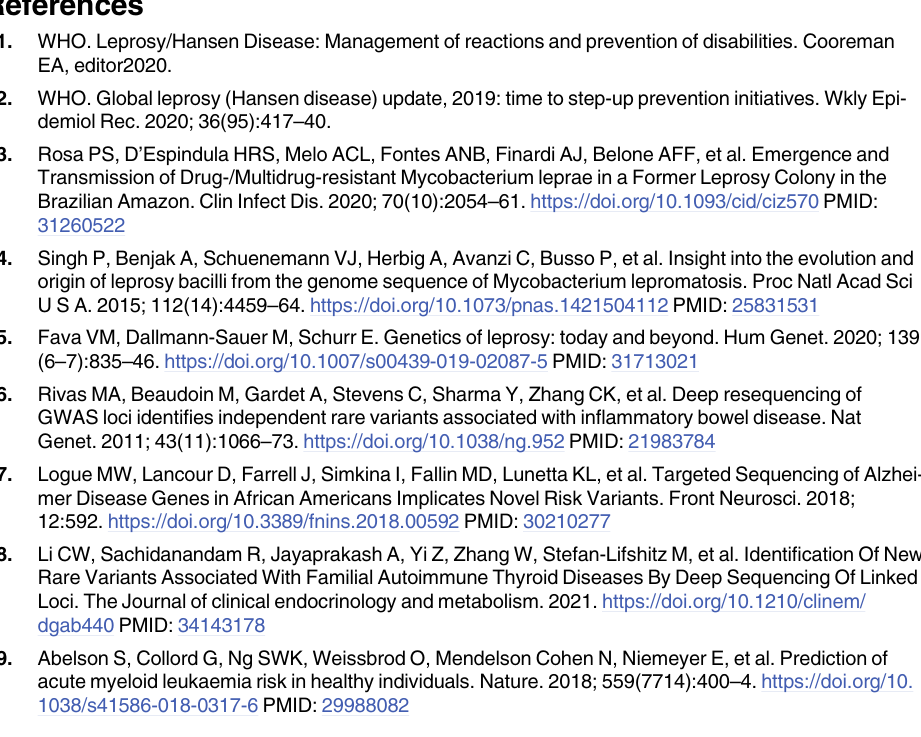
S2 Table. Summary of the 770 transcribed variants in the targeted